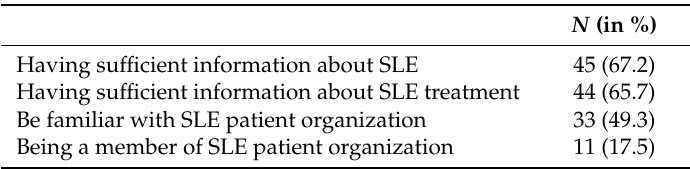
Table 5. SLE awareness among SLE patients (in %, N = 67).